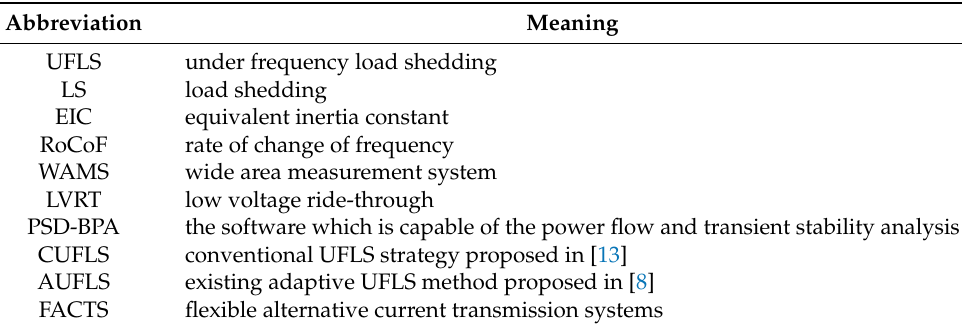
Table A3. The abbreviation and its